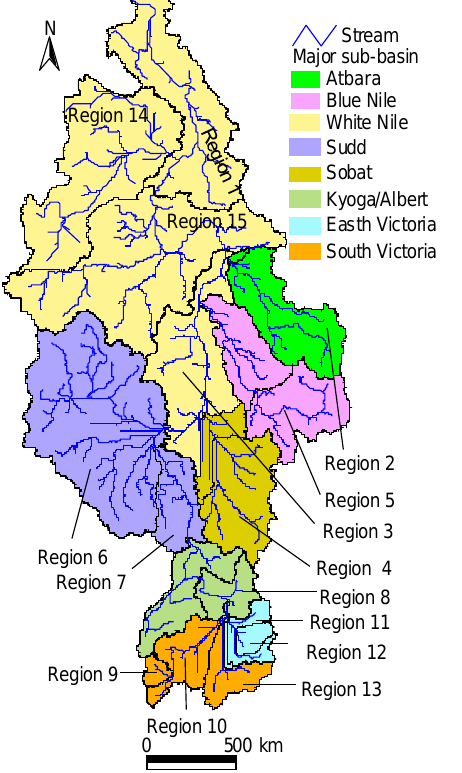
Fig. 4. Map showing overlay of delineated regions onto major catch- ments, and DEM based delineated river system of the Nile